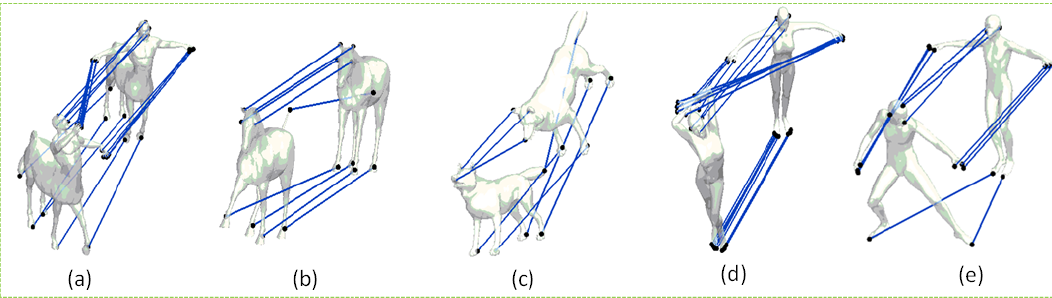
Figure 6. Application of our framework to correspondence analysis on the models of ( a ) centour, ( b ) horse, ( c ) dog, and ( d , e ) humans (here, we just show the representative lines for visual